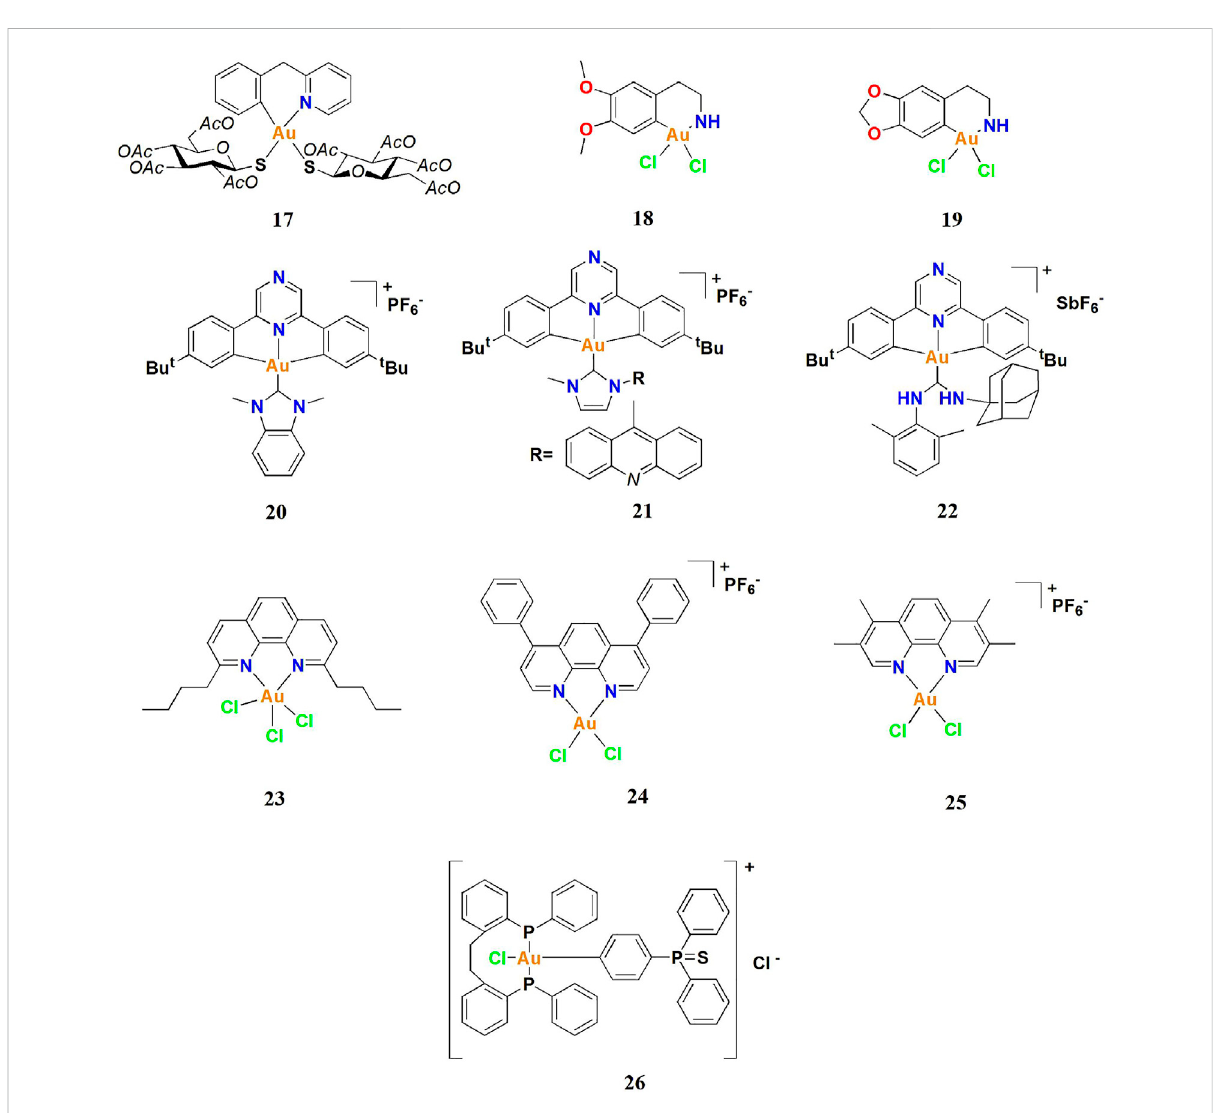
FIGURE 10 Anti-lung cancer gold (III)